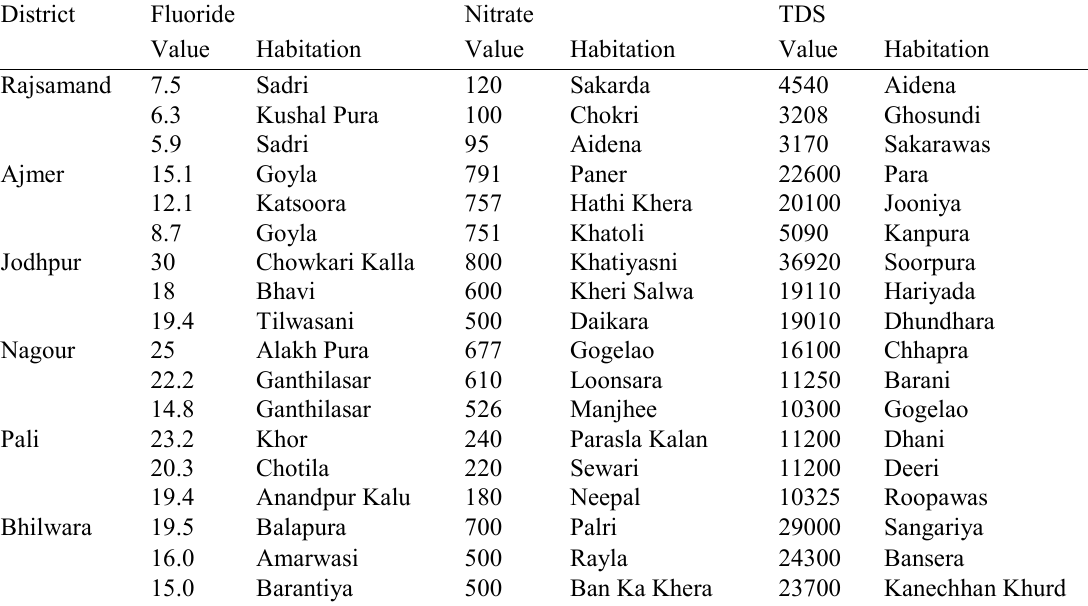
Table 5 Top three habitations with maximum concentration of contaminants.